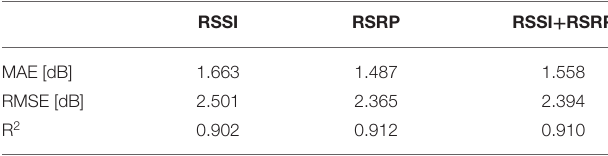
TABLE 4 | Performance comparison with different inputs.